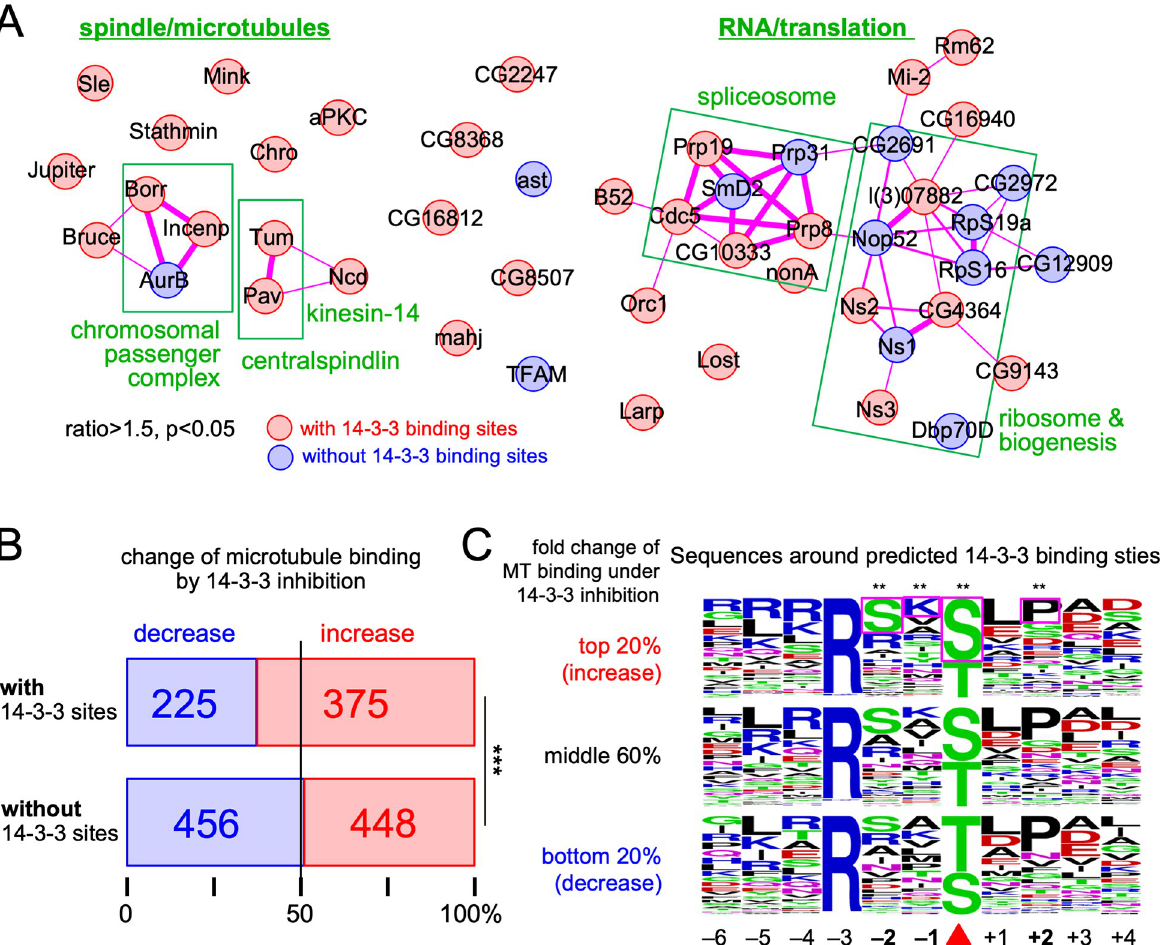
Fig 2. Bioinformatics analysis. (A) Physical protein-protein interactions known among 47 proteins that significantly increased their microtubule binding under 14-3-3 inhibition (the fold change > 1.5 and p < 0.05; the boxed area in Fig 1C). Red and blue indicate proteins with at least one predicted 14-3-3 binding sites and without them, respectively. The lines indicate physical interactions and their thicknesses indicate confidence levels of evidence. (B) The numbers and proportions of proteins with or without predicted 14-3-3 sites that increased or decreased in the microtubule fractions by 14-3-3 inhibition. (C) Sequences around predicted 14-3-3 binding sties among proteins with top 20%, middle 60% and bottom 20% of all detected proteins in the order of the fold change in microtubule fraction in the presence of the 14-3-3 inhibitor. Coloured boxes indicate the residues whose frequencies are significantly different among the top 20% than the frequencies among the rest of proteins. �� indicates p <